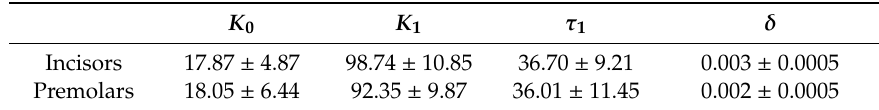
Table 4. Fitting parameters of the one-exponential function for temperature drop during polishing with water cooling, showing the average for all tested samples (n =